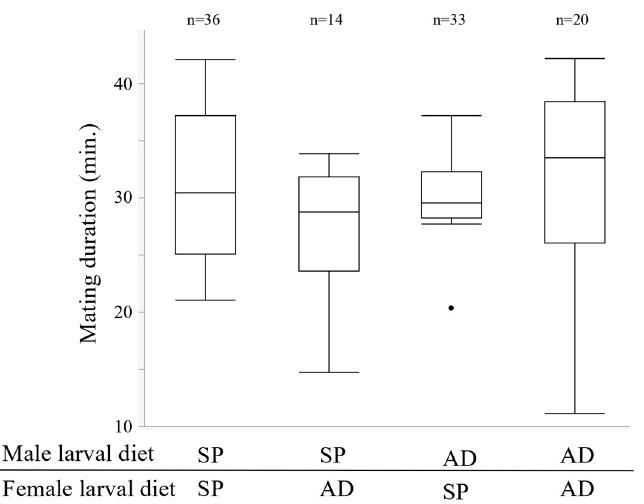
Figure 2. Effects of the male and female larval diet on the mating duration (min.). Boxplots represent medians (thick lines), the first and third quartile ranges (box perimeters), minimum and maximum (whiskers), and outliers (small circles). The explanation of the Y-axis is the same as in Figure